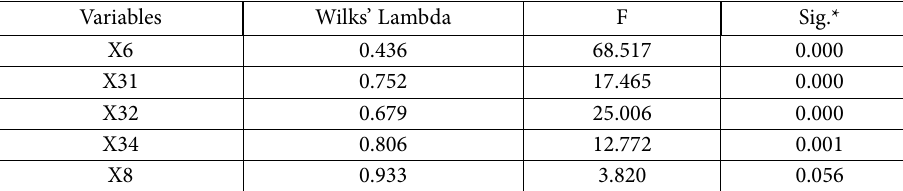
Table 2. Tests of equality of group means (source: authors’ processing) Variables Wilks’ Lambda F Sig.*